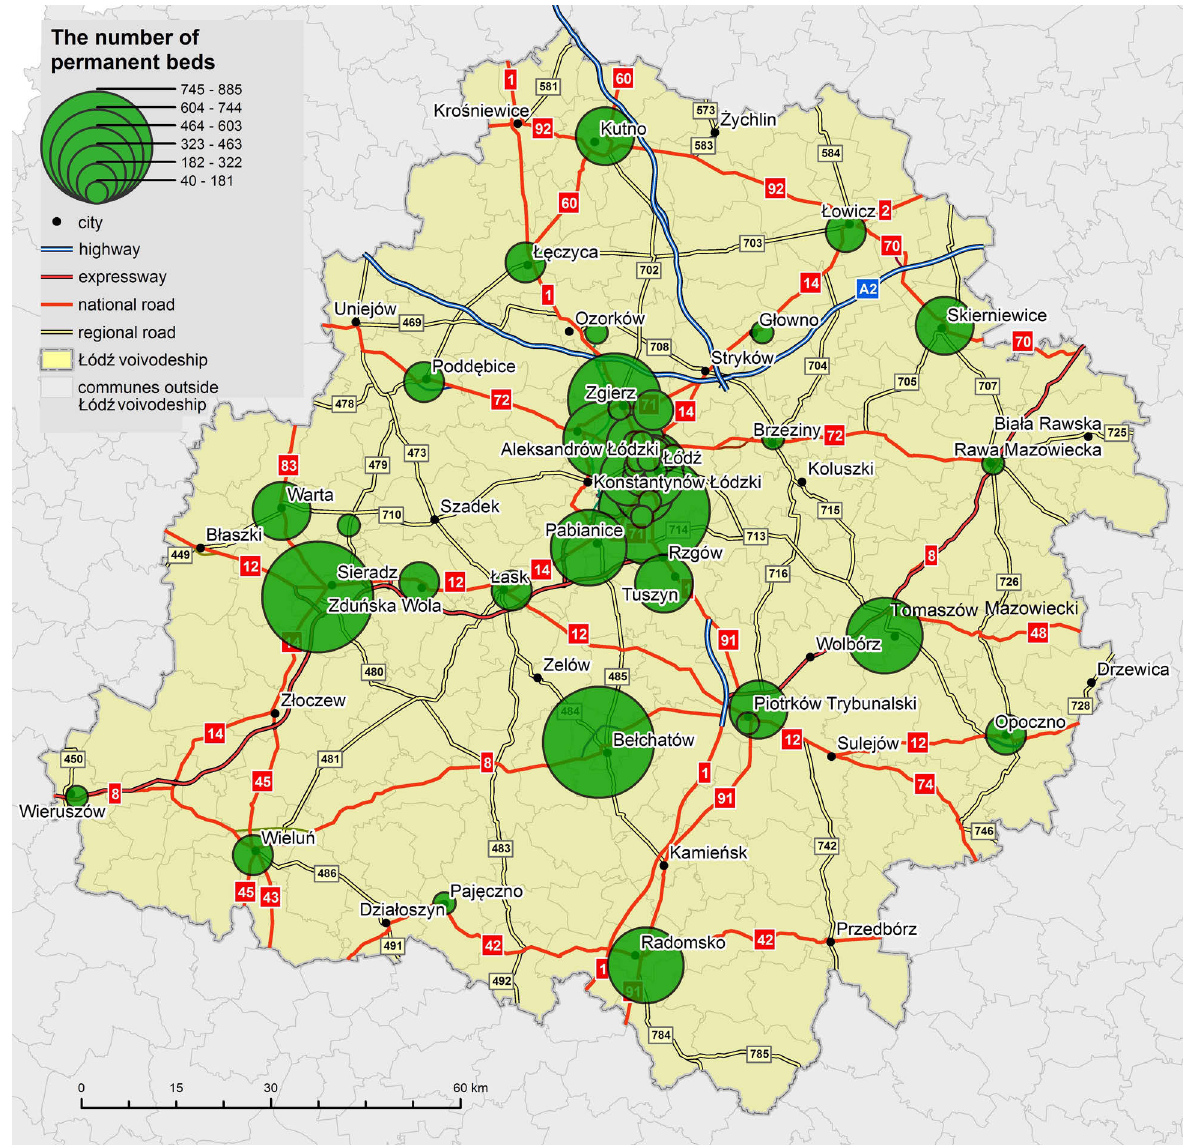
Fig. 1. Number of permanent beds in the hospitals of Łódź voivodeship in 2014. Source: author’s own work on the basis of the Operational Plan for Emergency Medical Services for Łódź voivode- ship of June 23,